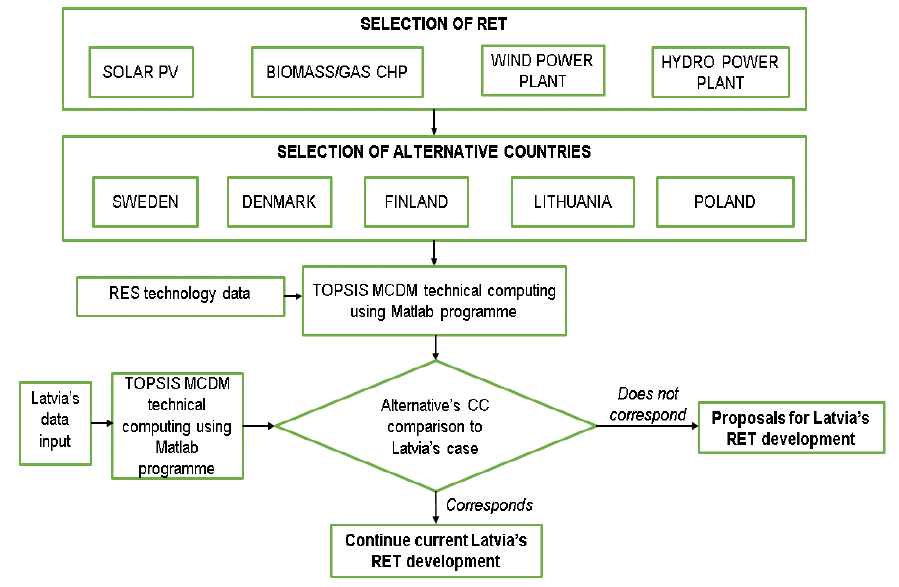
Fig. 2. Simplified scheme of research